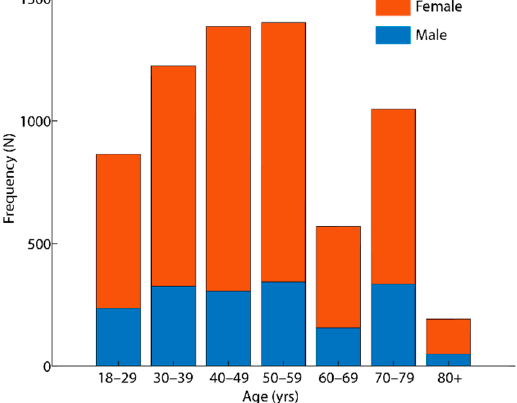
Figure 1. Frequency of ocular adverse events by age after vaccination against COVID-19 in 6688 reports to the VAERS database, 2020–2021.